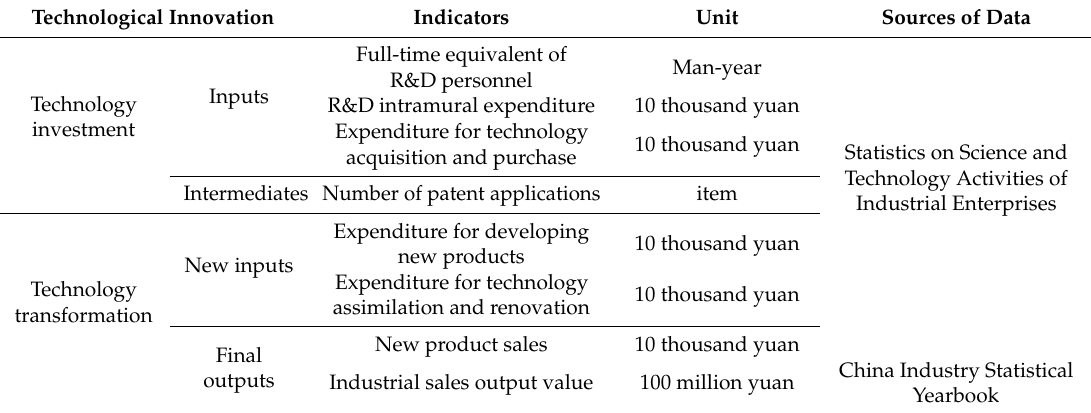
Table 2. Indicators for evaluating the e ffi ciency of Technological Innovation and data